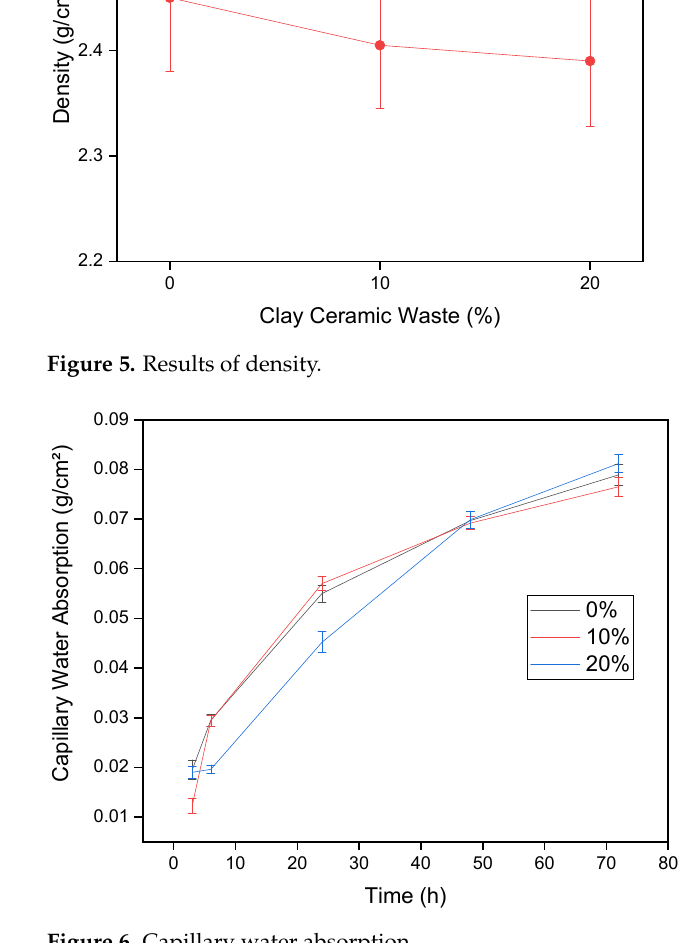
Figure 6. Capillary water absorption.